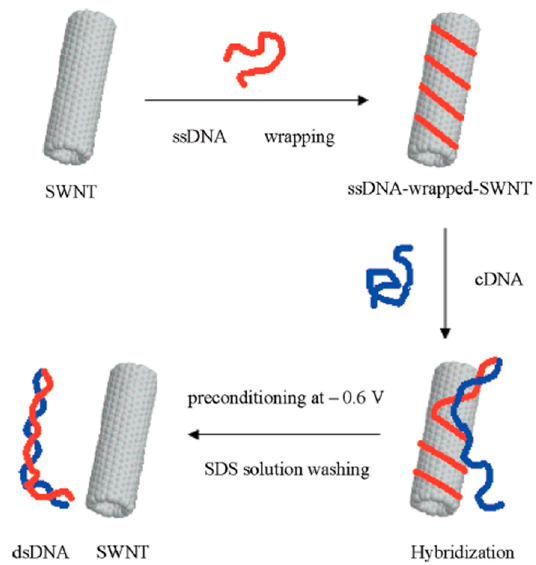
Figure 15. Schematic illustration of the interaction between SWCNT and DNA [136].